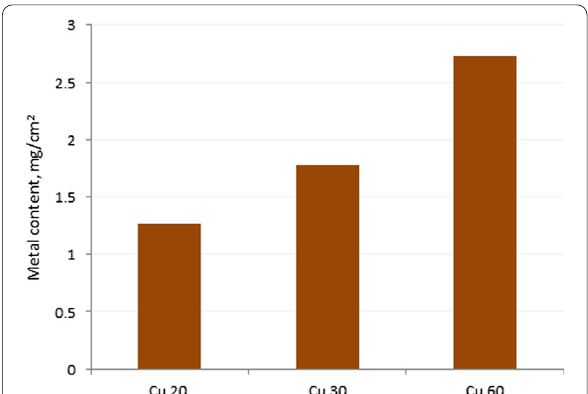
Fig. 6 Determination of Cu content (mg/cm 2 ) of electrolytically colored Al samples at different anodization time of 20, 30 and 60